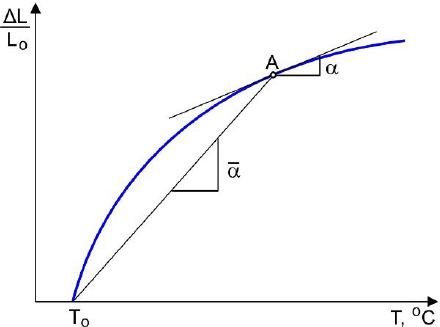
Figure 5. Determination of the coefficients of thermal expansion at point A.